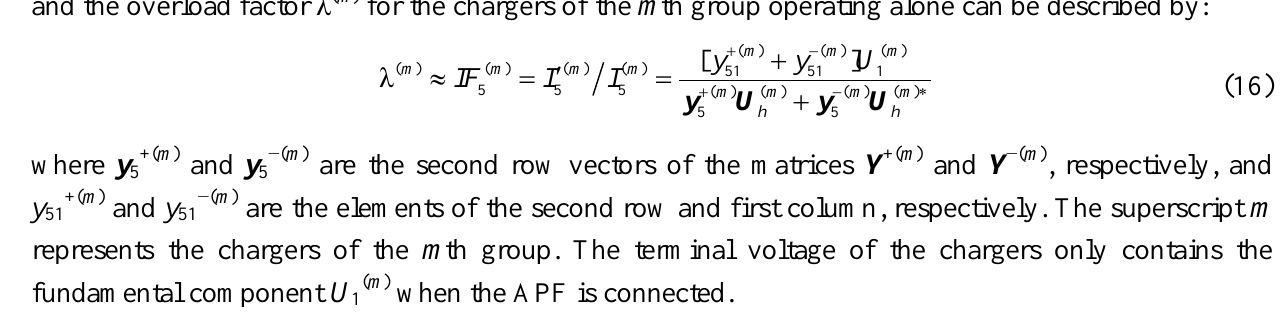
Figure 9. Equivalent circuit of charging